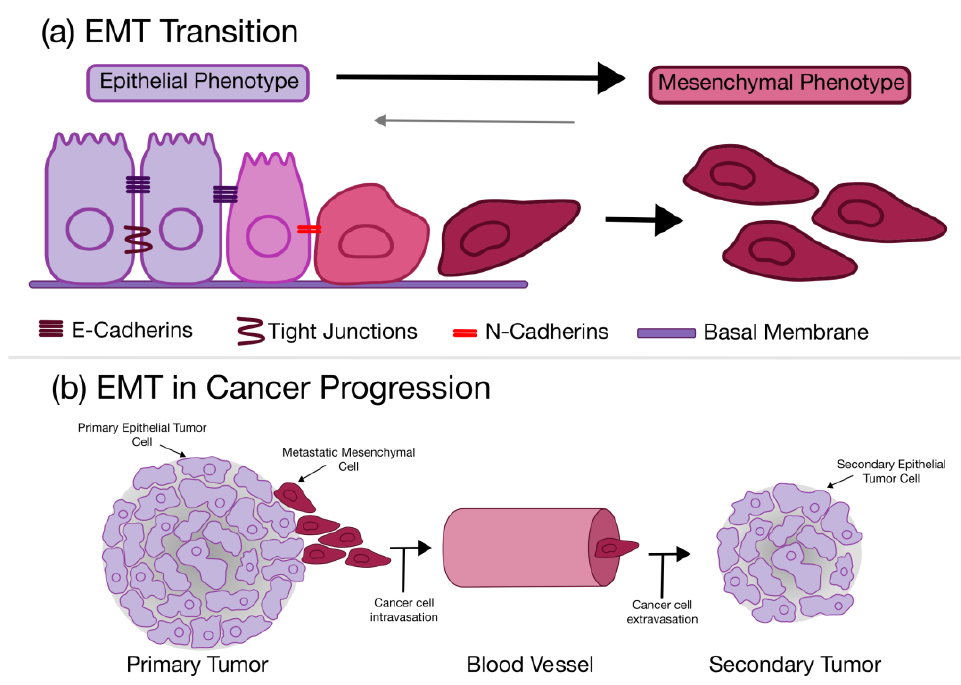
Figure 3. The epithelial to mesenchymal transition (EMT) as it relates to cancers. ( a ) General over- view of the transition and cell phenotype during the EMT; ( b ) The role of the EMT in cancer metas- tasis and progression.